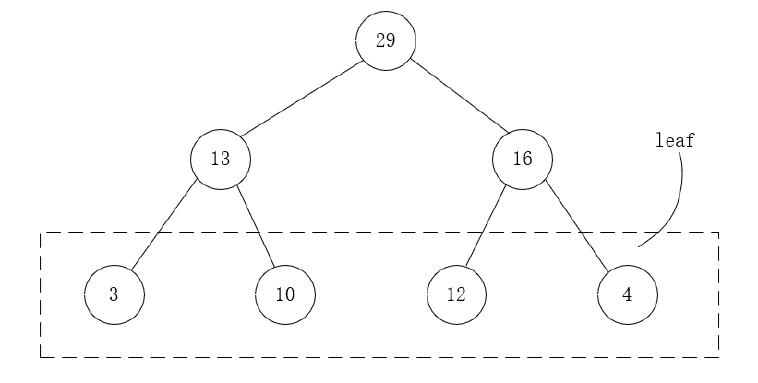
Figure 9. The framework of